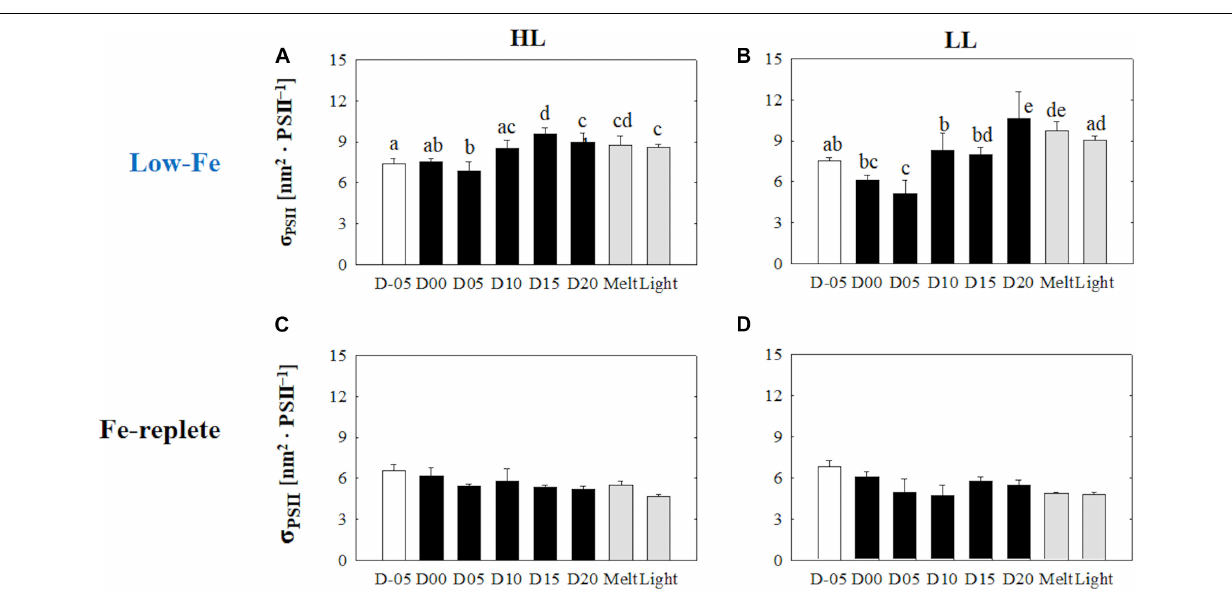
FIGURE 4 | Functional absorption cross-section of PSII ( σ PSII ) at each sampling time point during the ice tank incubation experiments. Panels (A,B) show σ PSII values of the low-Fe ice tank runs in this study, whereas panels (C,D) show those of Fe-replete ice tank runs modified from Yoshida et al. (2020). Left (A,C) and right (B,D) panels indicate data from the HL and LL treatments, respectively. Open, closed, and shaded bars indicate values of pre-freeze seawater, ice, melted seawater samples, respectively. Letters above bars in a panel indicate significant differences in values between sampling days and light treatments with one-way/two-way ANOVA with Tukey’s test; there is no significant difference between values if a given letter is shown in the combination of letters of the counterparts. The D stands for “day,” while Melt and Light indicate values after melting and light exposure experiments, respectively. Error bars show 1 standard deviation ( n = 6). One-way ANOVA with Tukey’s test, HL: F ( 7 , 47 ) = 18.80, p < 0.001; LL: F ( 7 , 47 ) = 21.98, p < 0.001. Two-way ANOVA test with Tukey’s test, Light: F ( 1 , 90 ) = 1.37, p > 0.05; Day: F ( 7 , 90 ) = 20.04, p < 0.001; Light*Day: F ( 7 , 90 ) = 2.13, p > 0.05. The results of Tukey’s tests, as q -values, are given in the